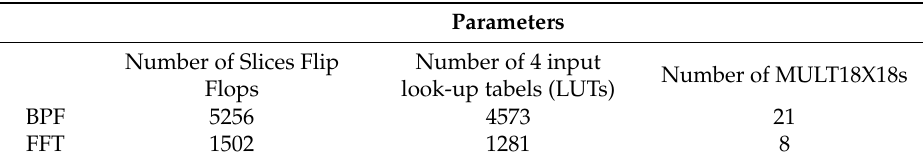
Table 2. Implementation complexity analysis (XC3S1000).